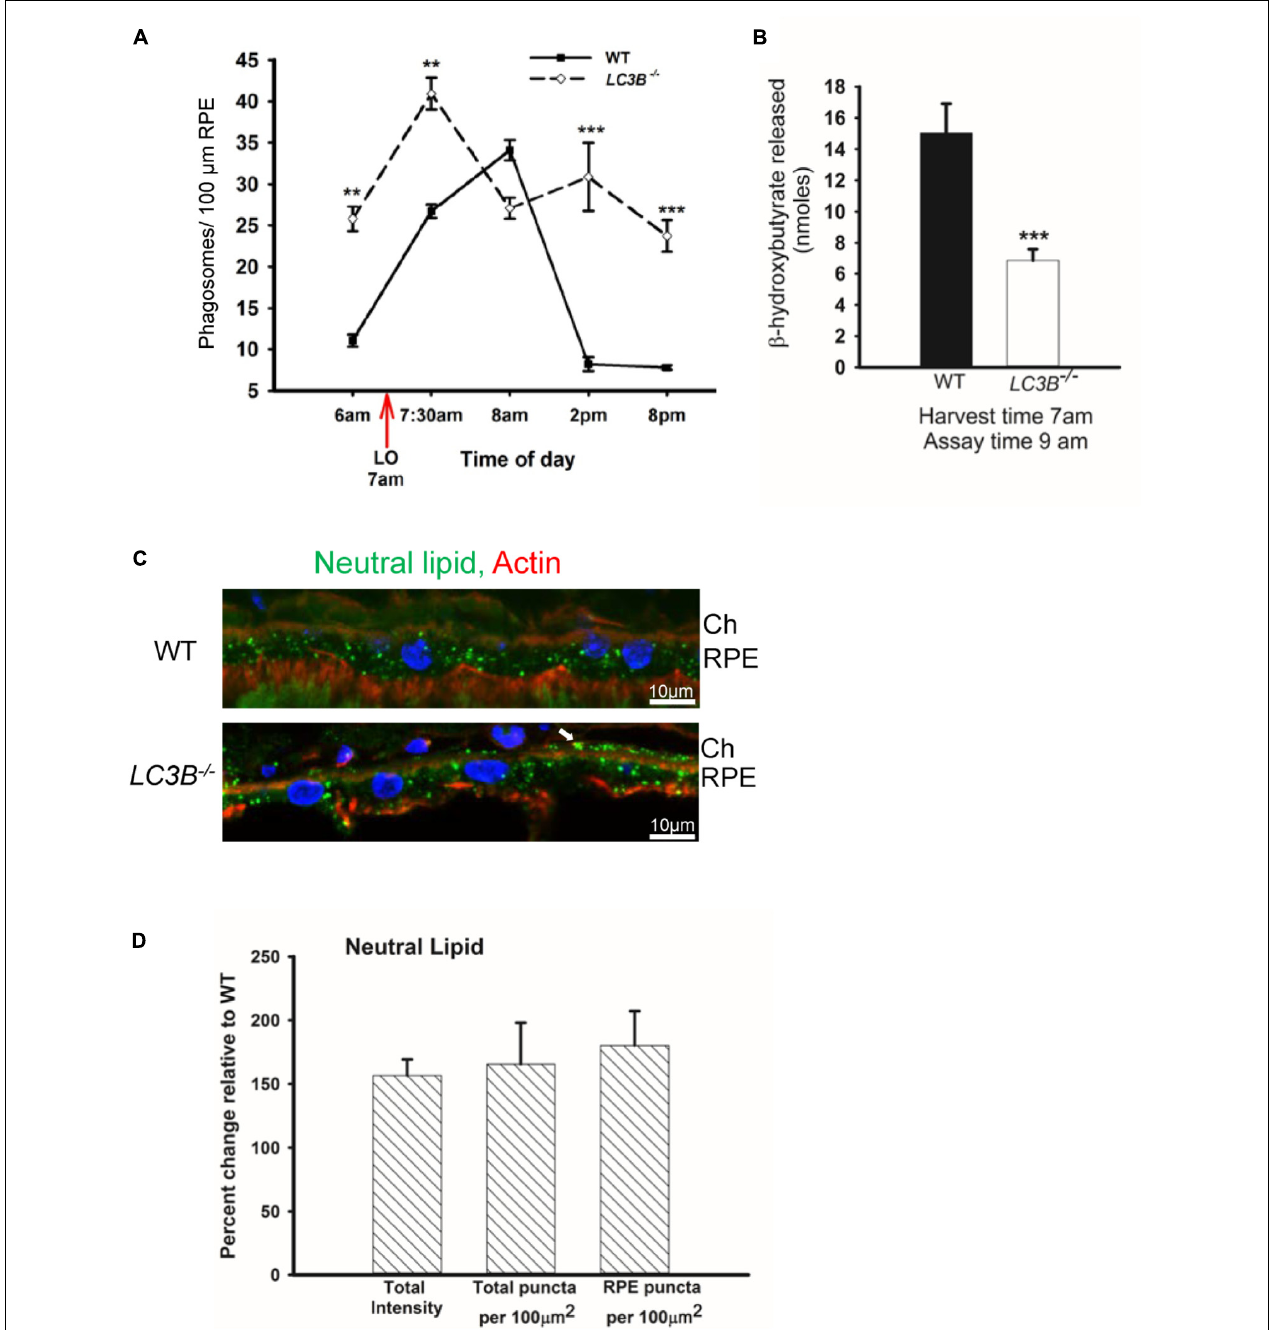
FIGURE 4 | Loss of LC3B results in phagosome and neutral lipid accumulation. (A) Phagosomes per 100 µ m of RPE length in WT and LC3B − / − mice ( ∼ 4 months old) at different times of day relative to light onset (LO is at 7 am); lights were turned off at 7 pm. Phagosomes were counted under masked conditions, in duplicate on 15 different areas per mouse. Values are mean ± SEM of two eyes, 15 regions per eye. ∗∗ p < 0.005, and ∗∗∗ p < 0.002. (B) β -HB released from RPE explant harvested at light onset (7 am) and assayed at 9 am in WT and LC3B − / − mice (12–15 months old). Values are mean ± SEM from 4 individual mice. ∗∗∗ p < 0.002. (C) Representative confocal image of neutral lipid deposits detected by staining with BODIPY 493 / 503 in WT and LC3B − / − RPE (18 months) nuclei (blue) stained with HOECHST, Ch – choroid. (D) Intensity of BODIPY 493 / 503 staining was quantified and puncta localized as indicated. Values are mean ± SEM from 3 individual mice ( ∼ 18 months), ∗ p <